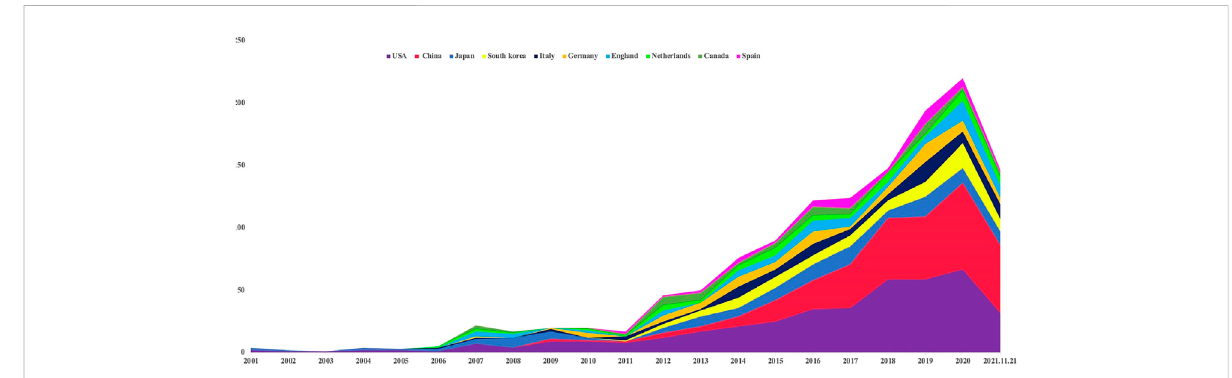
FIGURE 2 Top 10 most productive countries. Countries are indicated by colors, where the width of the color plate indicates annual publications per